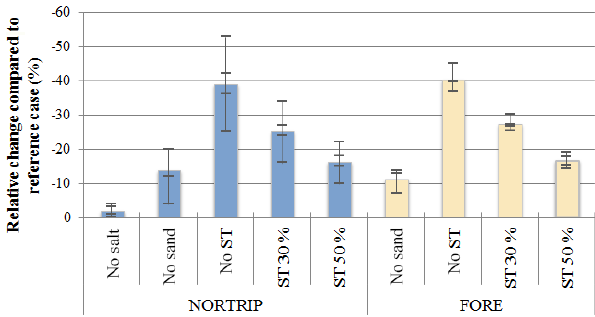
Figure 5. Modelled relative changes in the non-exhaust street incre- ment of PM 10 for the cases described in Table 6, averaged over the four years (2007–2009 and 2014). Line markers show values for the individual